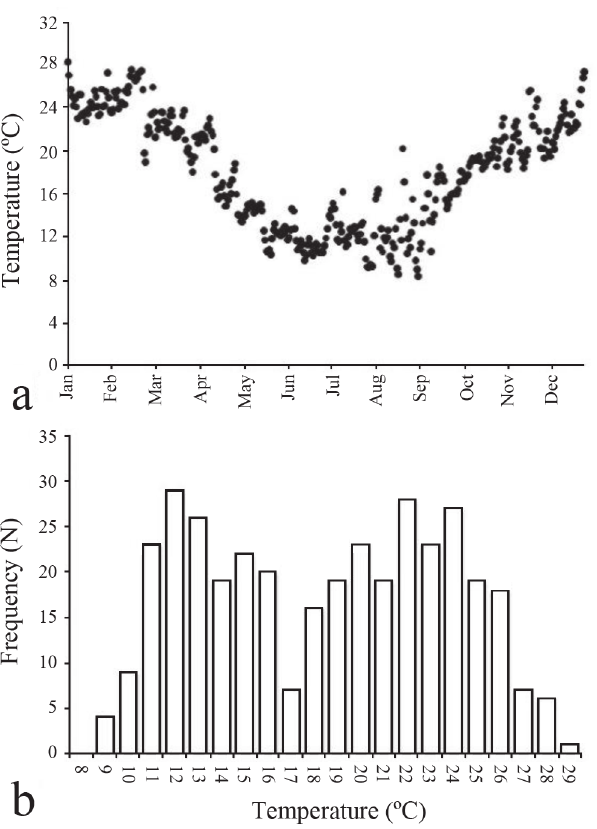
Fig. 2. Average daily water temperatures registered at Yalca Lake during an annual cycle ( a ), and frequency distribution of the average daily temperatures ( b ).